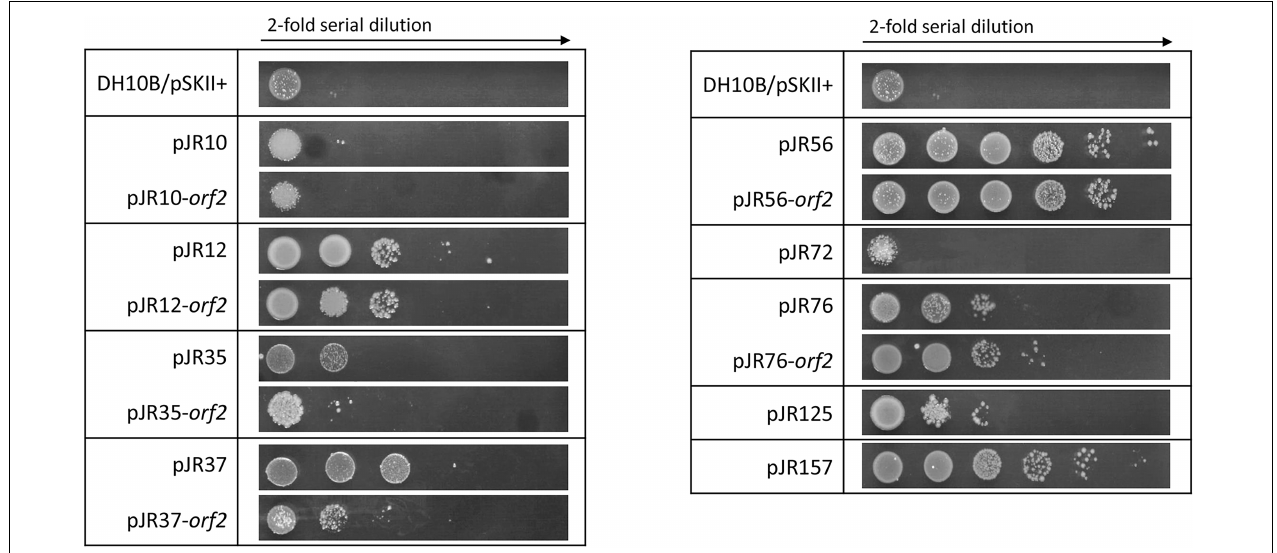
FIGURE 6 | Hydrogen peroxide resistance test by drop assays of the individual predicted ORFs involved in perchlorate resistance and their complete clones. Cultures were grown overnight at 37 ◦ C, drops of 2-fold serial dilutions were plated on LB-Ap supplemented with 1 mM H 2 O 2 and plates were incubated for 24 h at 37 ◦